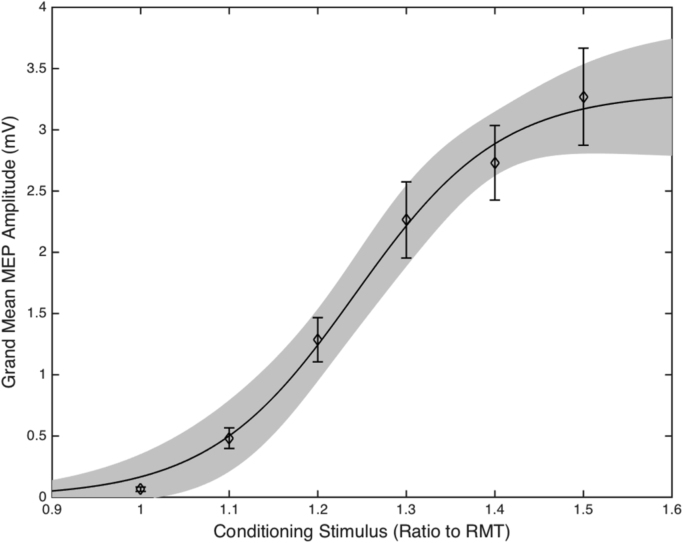
Group mean of individual median MEPs following stimulation of 100–150% of individual RMT. The errors bars are SEM and the shaded region is the 95% confidence intervals of the sigmoidal function fitted to the data.